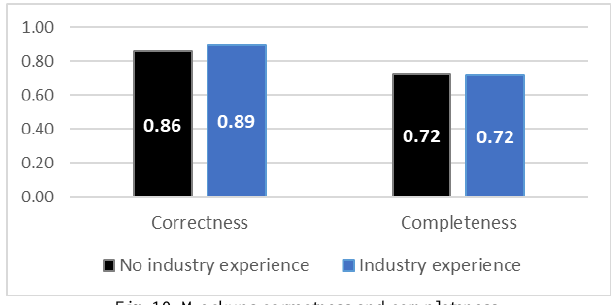
Fig. 10. Mockups correctness and completeness.